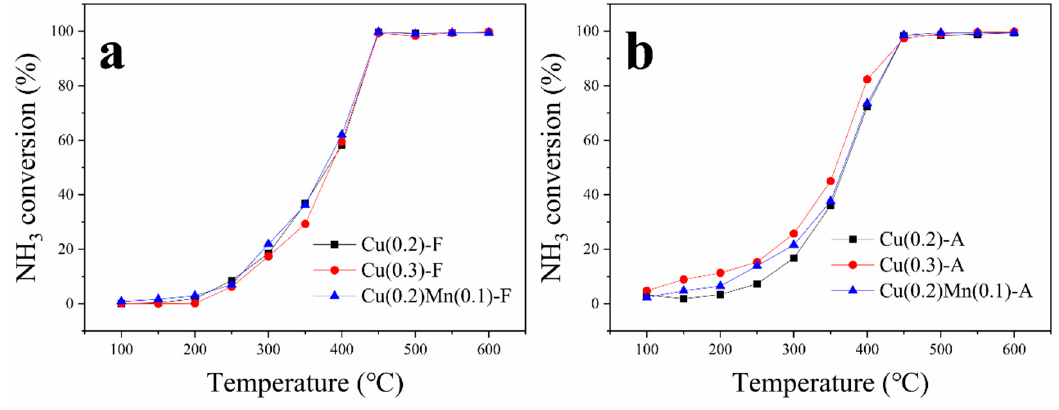
Figure 3. NH 3 oxidation of catalysts before ( a ) and after ( b ) hydrothermal aging under a GHSV of 30,000 h − 1 .